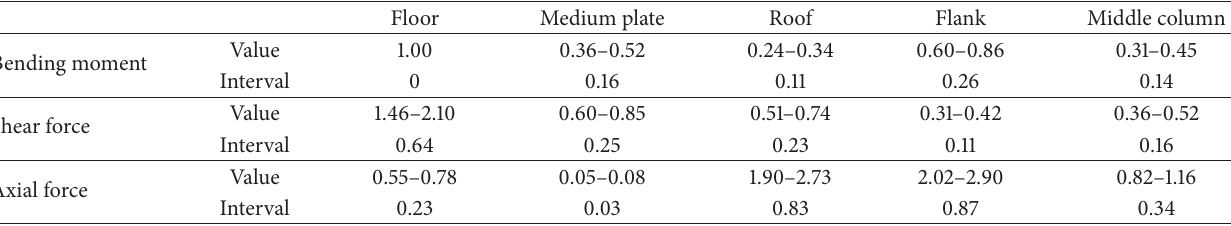
Table 5: The range of internal force correction coefficient on the basis of the equivalent inertial force method.